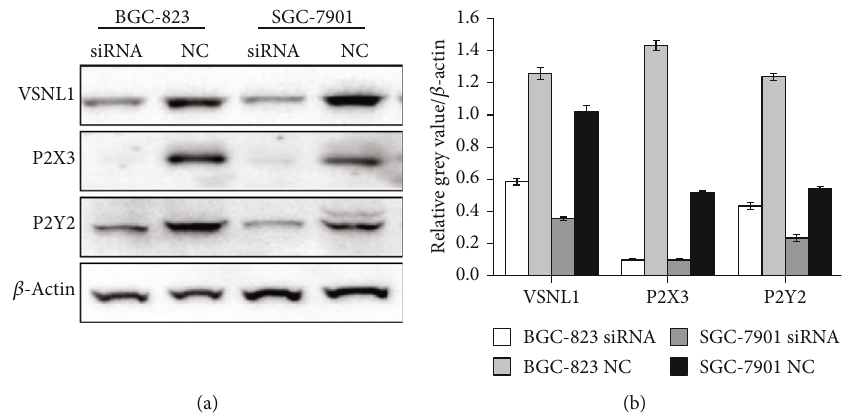
Figure 7: The e ff ect of VSNL1 on the expression of P2X3/P2Y2. We repeated each experiment three times. Substantially decreased P2X3/P2Y2 expression was found in BGC-823 and SGC-7901 cells 72h after infection with VSNL1